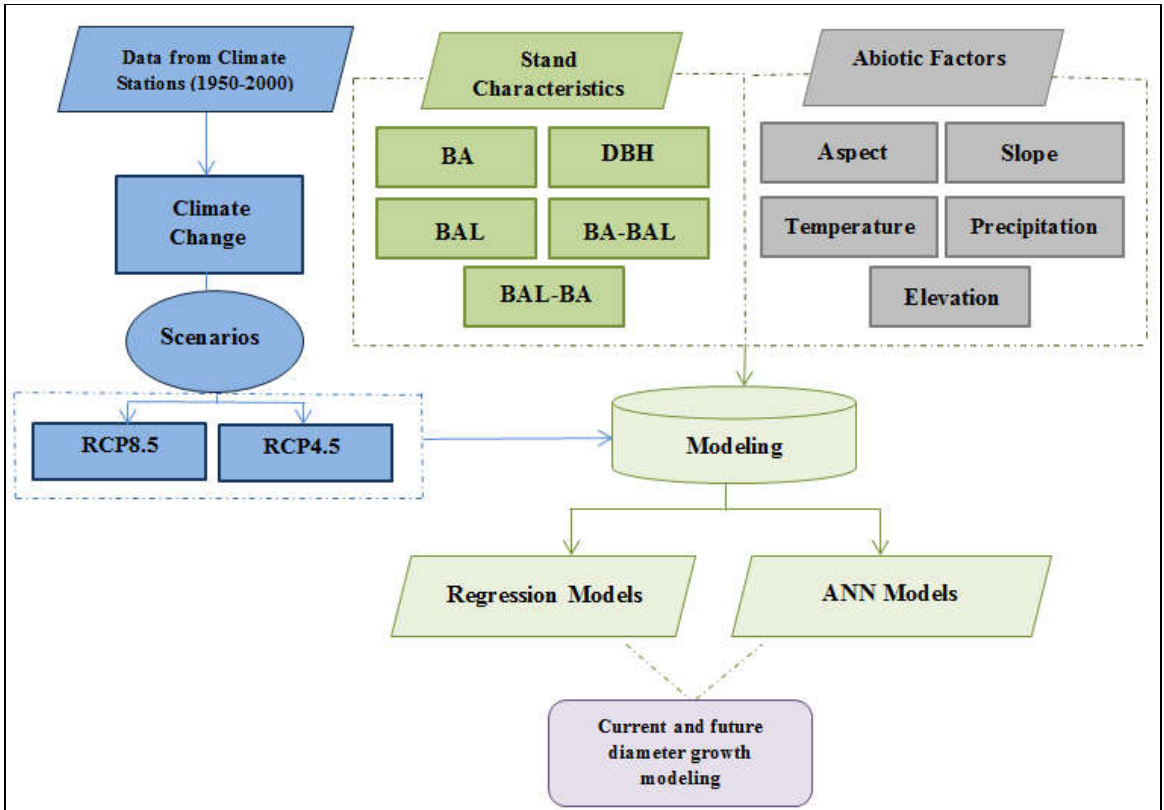
Figure 2. Flowchart of the main research steps. RCP8.5 and RCP4.5 are two scenarios of Representa- tive Concentration Pathway, BA is basal area (m 2 ha −1 ), BAL is basal area in largest trees (m 2 ha −1 ), DBH is diameter at breast height (cm), and ANNs is Artificial Neural Networks.